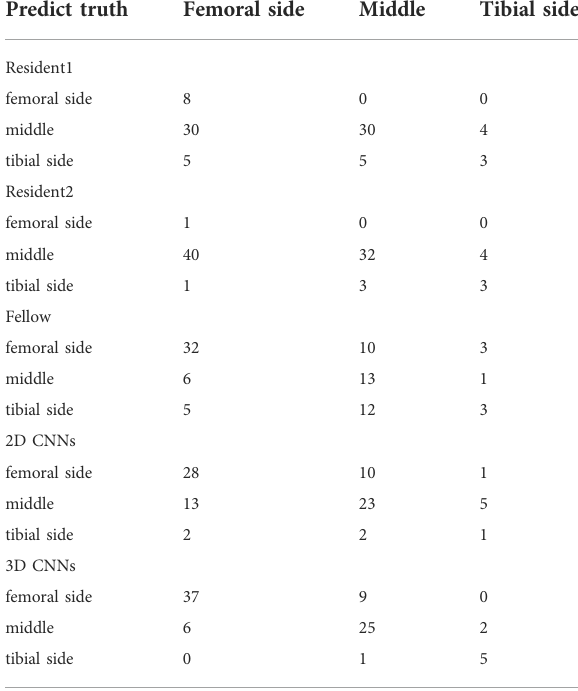
TABLE 4 Confusion matrices for the clinical residents, musculoskeletal radiology fellow, 2D CNNs, and 3D CNNs for performancein sides classifying of ACL ruptureon